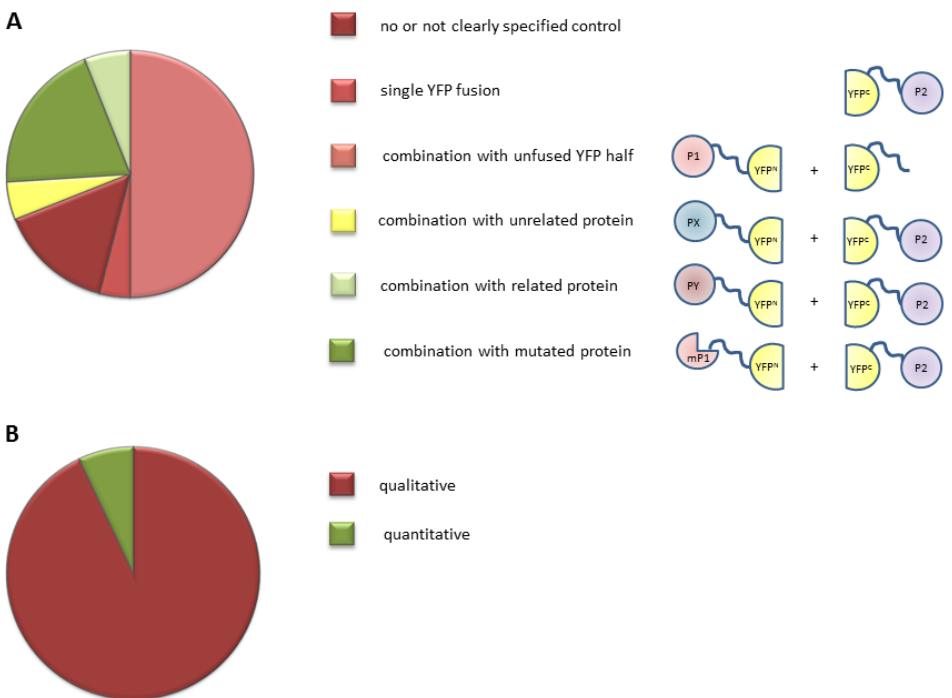
Figure 2. Survey of experimental set-up used in plant BiFC experiments. ( A ) Negative controls used in recent BiFC experiments. The suitability of a control is scaled using shading from dark red (the worst) to dark green (the best). The red classes indicate controls with a higher incidence of detecting false positives. The green classes represent suitable controls. The yellow class indicates a control of intermediate quality. Schematic representations of the controls are shown to the right. P1 and P2 represent the two proteins of interest, PX and PY indicate proteins that are related and unrelated, respectively to the protein of interest, and mP1 represents a mutant or truncated version of P1; ( B ) Percentage of BiFC experiments in which a qualitative ( red ) or quantitative ( green ) read-out of the fluorescence signal was